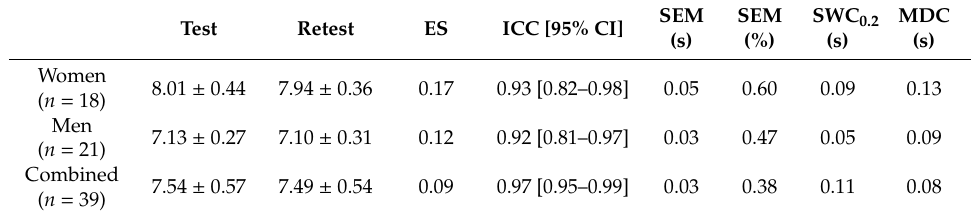
Figure 3. Receiver operating characteristics (ROC) curve for the SFCODT between high- and low-ranked fencer athletes. Table 3. Performance characteristics and results of absolute and relative reliability of SFCODT for fencer athletes *.